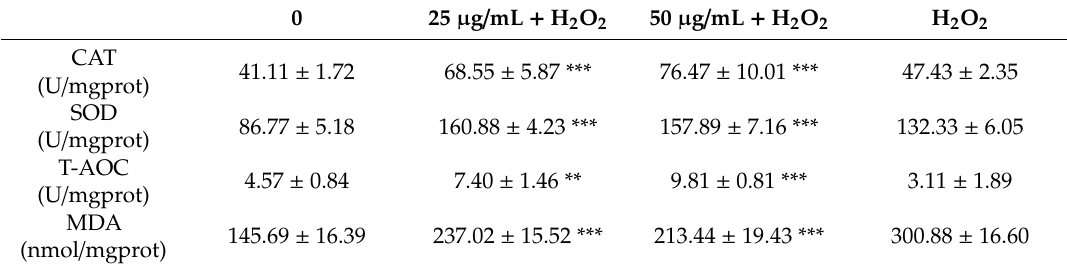
Table 3. The activities of antioxidant enzymes and content of Malondialdehyde (MDA) as well as total antioxidant